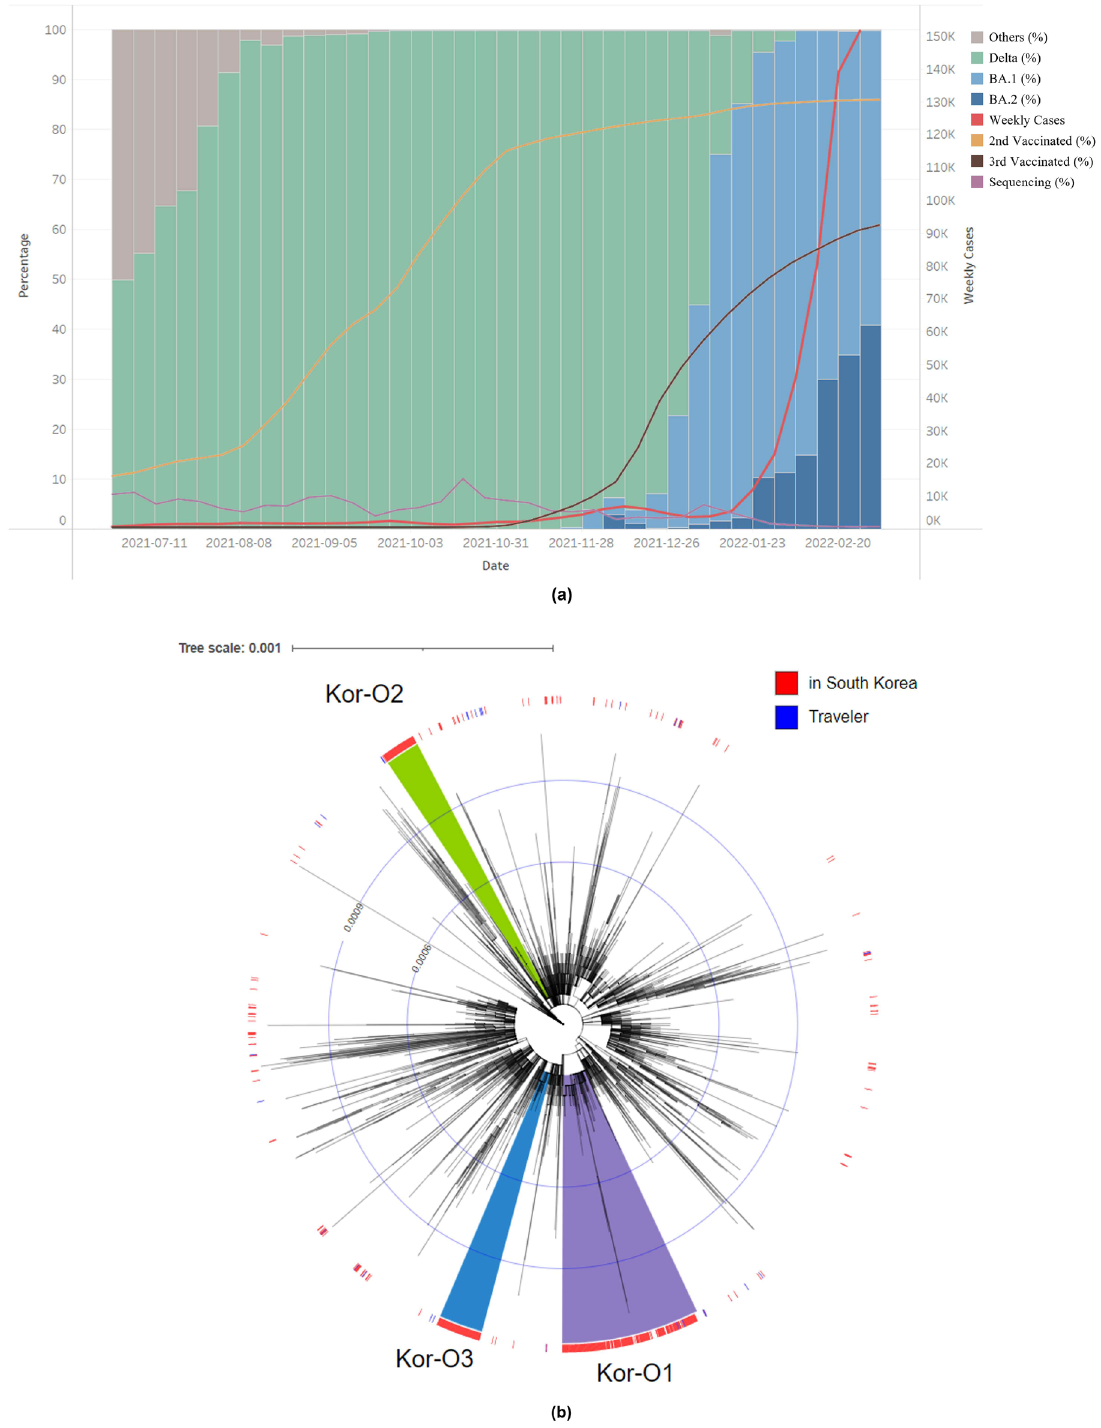
Figure 1. ( a ) Proportion of lineages and number of weekly cases of Korean sequences. Each column indicates the proportion of SARS-CoV-2 lineages of Korean sequences from July 7, 2021, to February 20, 2022. The red line indicates the number of weekly cases in South Korea from July 7, 2021, to February 20, 2022, and the yellow, brown, and purple lines indicate the 2nd vaccination rate, 3rd vaccination rate, and sequencing percentage. ( b ) Maximum-likelihood phylogenetic tree constructed by FastTree of 3330 foreign sequences and 582 Korean sequences. The SARS-CoV-2 viruses detected from travelers entering South Korea or their direct contacts were annotated by blue color strips, and viruses detected from South Korean residents with no travel history were annotated by red color strips. The Kor-O1 subgroup is highlighted in purple, Kor-O2 is highlighted in green, and Kor-O3 is highlighted in